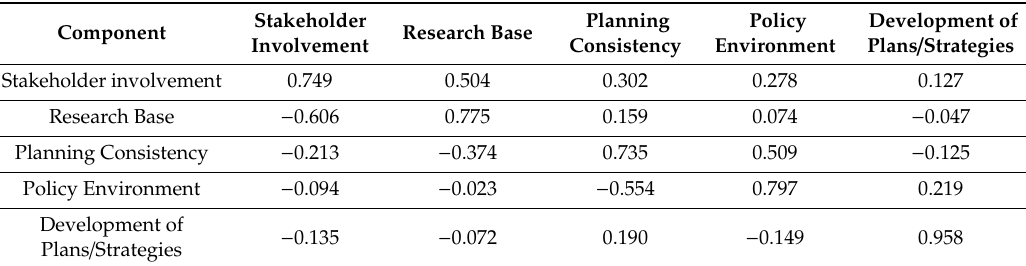
Table 5. Component transformation